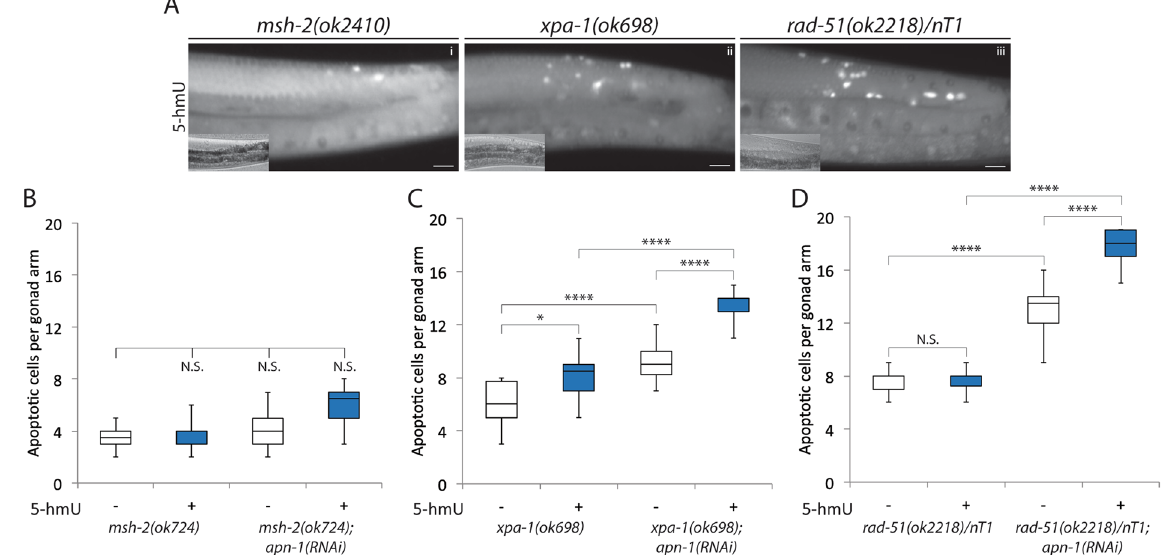
Figure 7. Mutants defective in the MMR, NER or HR pathway do not show significant increase in germ cell death upon exposure to 5-hmU. ( A ) Acridine orange stained and DIC images as described in Fig. 2. The images represent a component from each of the three additional main DNA repair pathways, [i] msh-2(ok2410) Mismatch Repair pathway, [ii] xpa-1(ok698) Nucleotide Excision Repair pathway and [iii] rad-51(ok2218) Homologous Recombination pathway, respectively. ( B – D ), Box and whisker plots depicting quantification of apoptotic corpses observed by the DNA repair defective mutants in the absence and presence of 5-hmU